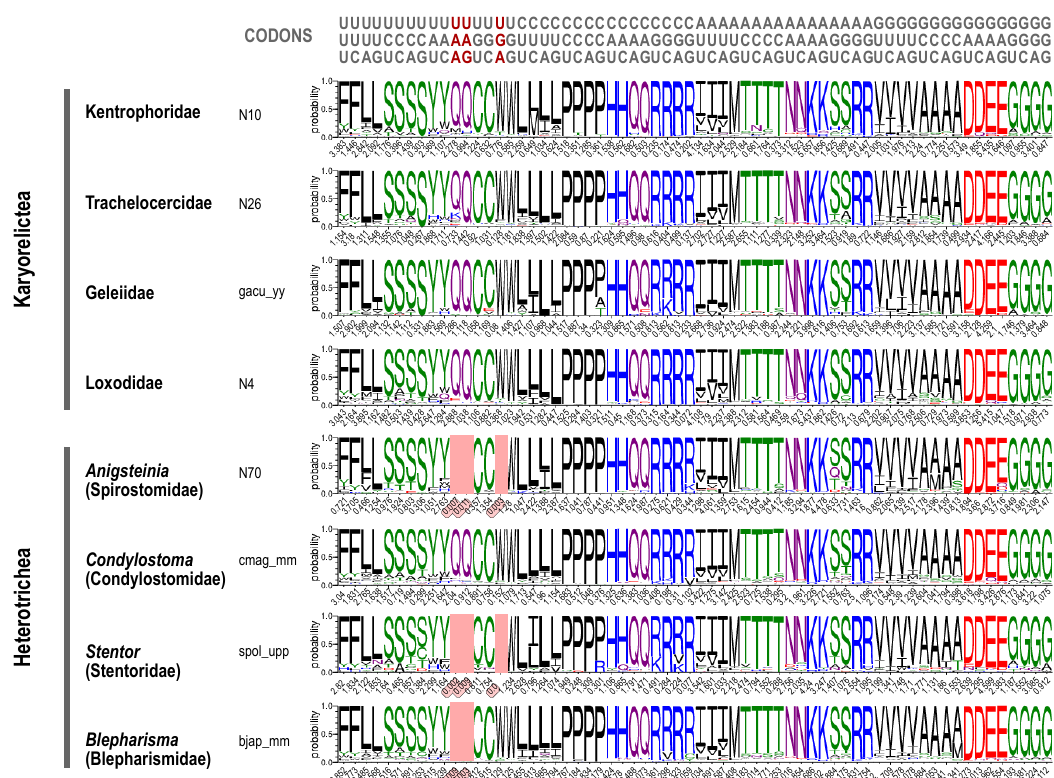
Figure 3 . Weblogos representing the likely amino acid assignment of each codon in selected libraries (library with most coverage per taxon of interest). Heights of each letter represent the relative frequencies (all scaled to 100%) of each amino acid in conserved residues aligning to that codon. The observed codon frequency (in %) is indicated below. Codons with frequencies <0.02% are highlighted in red, representing either non-ambiguous stops or unassigned codons. Assignment of cysteine (C) for UGA in Anigsteinia is based on only 16 alignments, of which 14 are to a likely selenoprotein (Pfam domain GSHPx); assignment of glutamine (Q) for UAA and UAG in Blepharisma may represent recent paralogs or translational